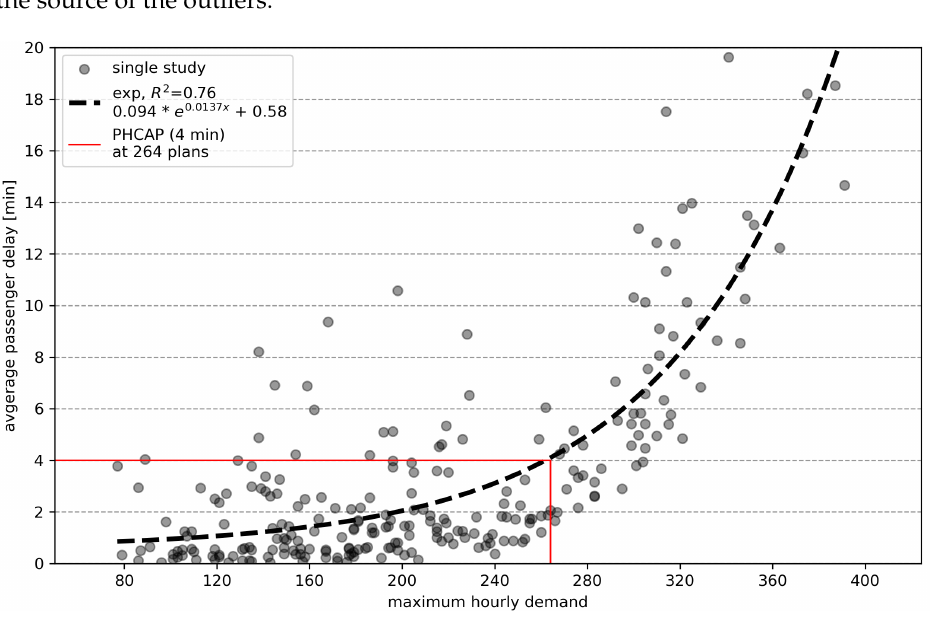
Figure 6. Analyzing the effect of peak-hour demand on the average passenger delay and identification of the practical hourly capacity